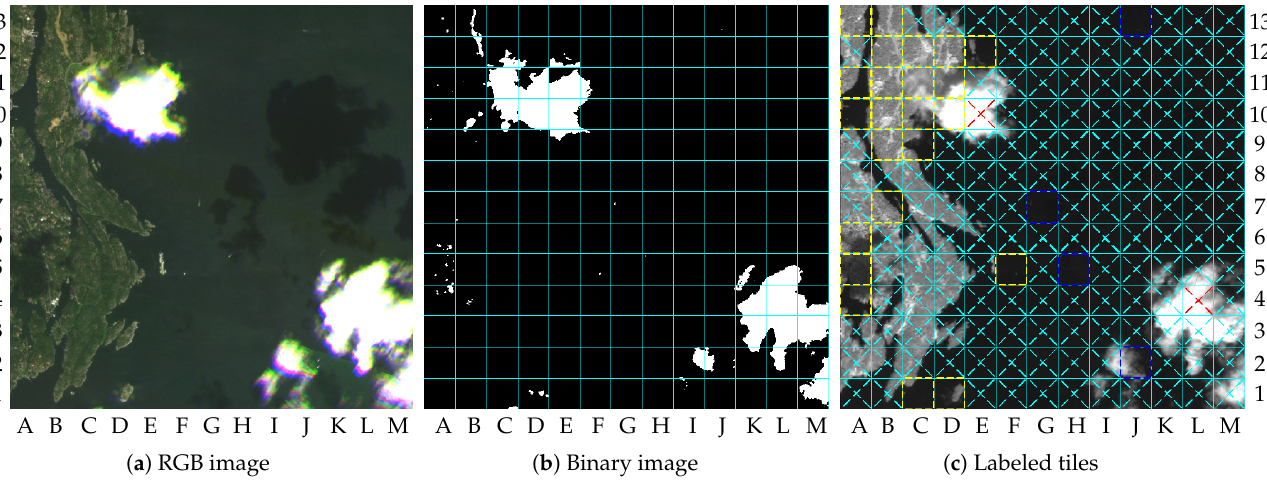
Figure 14. Results for image 12: ( a ) RGB image (truncated at 2000); ( b ) binary image; ( c ) labeled tiles (truncated at